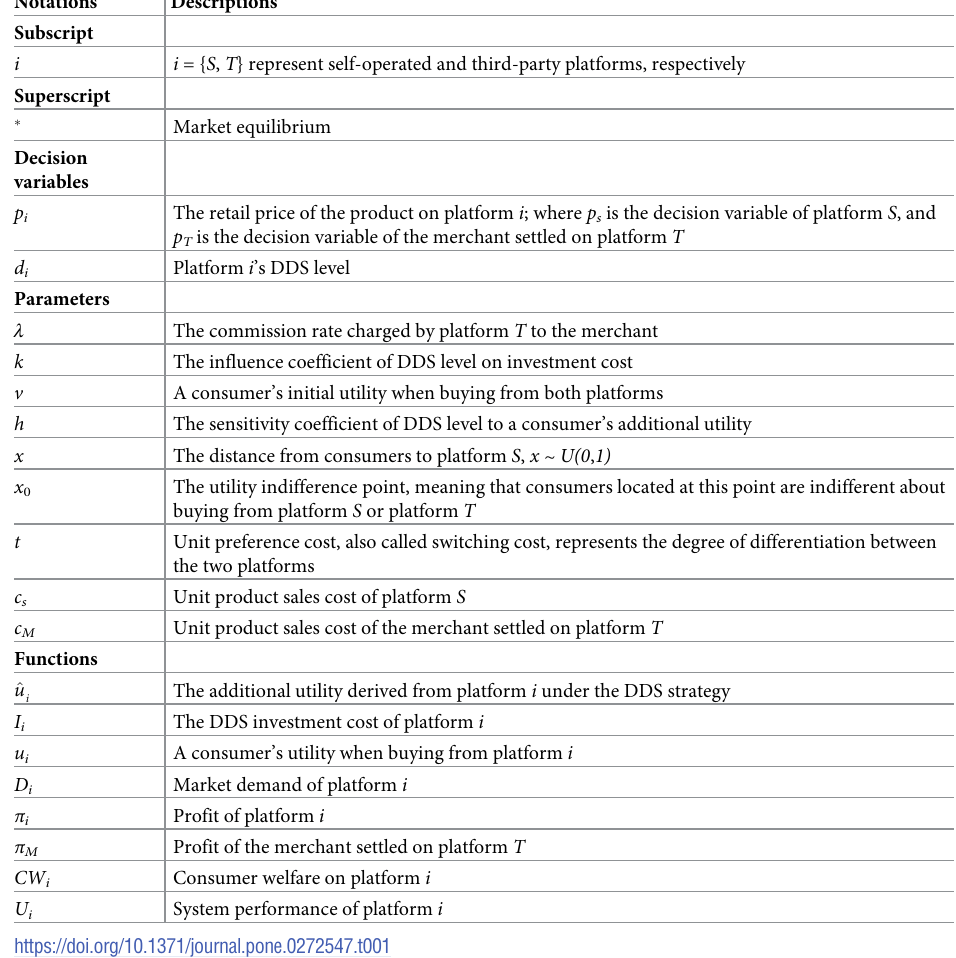
Table 1. Notations and descriptions for the